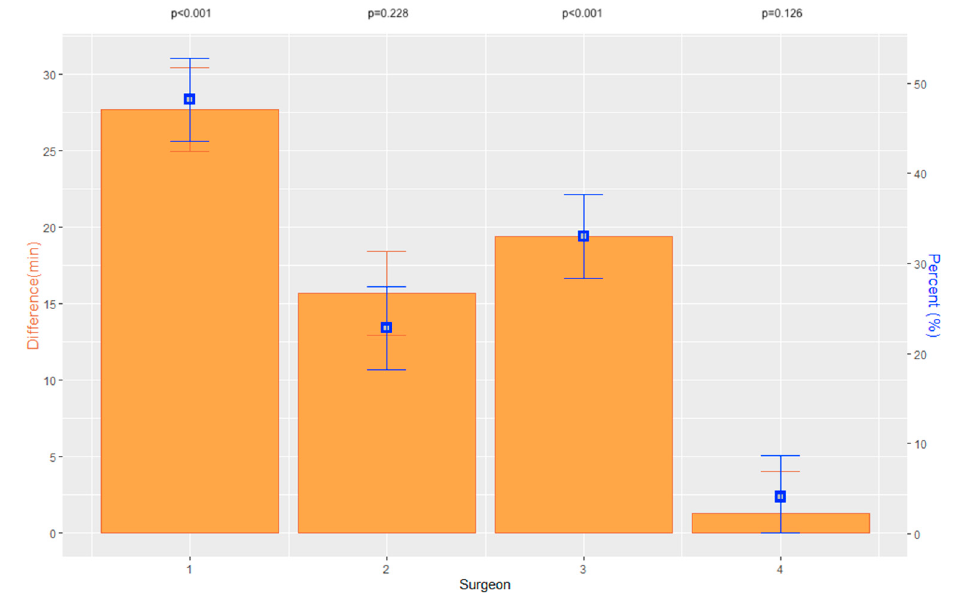
Figure 1. Graphs displaying the absolute difference of surgical duration of Triple-DMEK between period 1 and period 2 in minutes, including the standard error and p -values as well as the percentage difference for each surgeon.